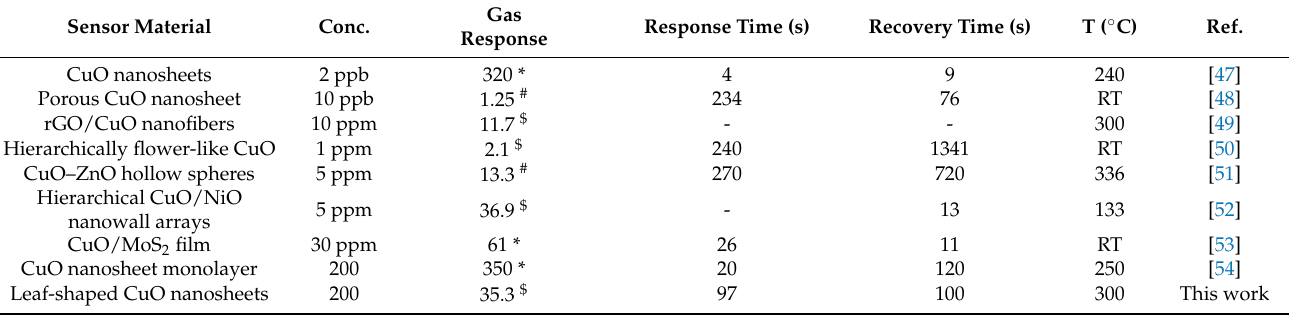
Table 2. Sensing parameters for various CuO gas sensor materials towards H 2 S gas. Sensor